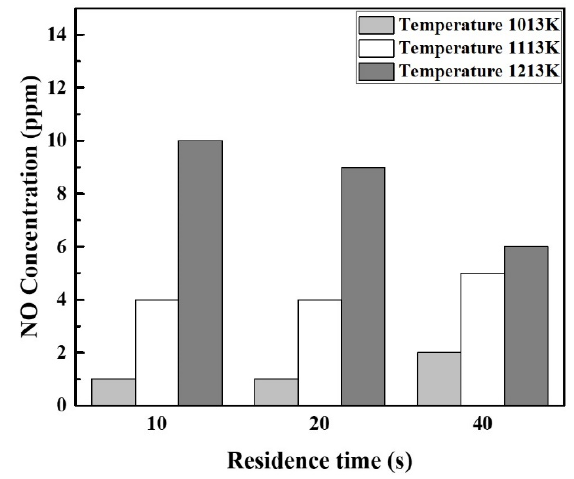
Figure 8. Dependence of the NO concentration on the residence time.